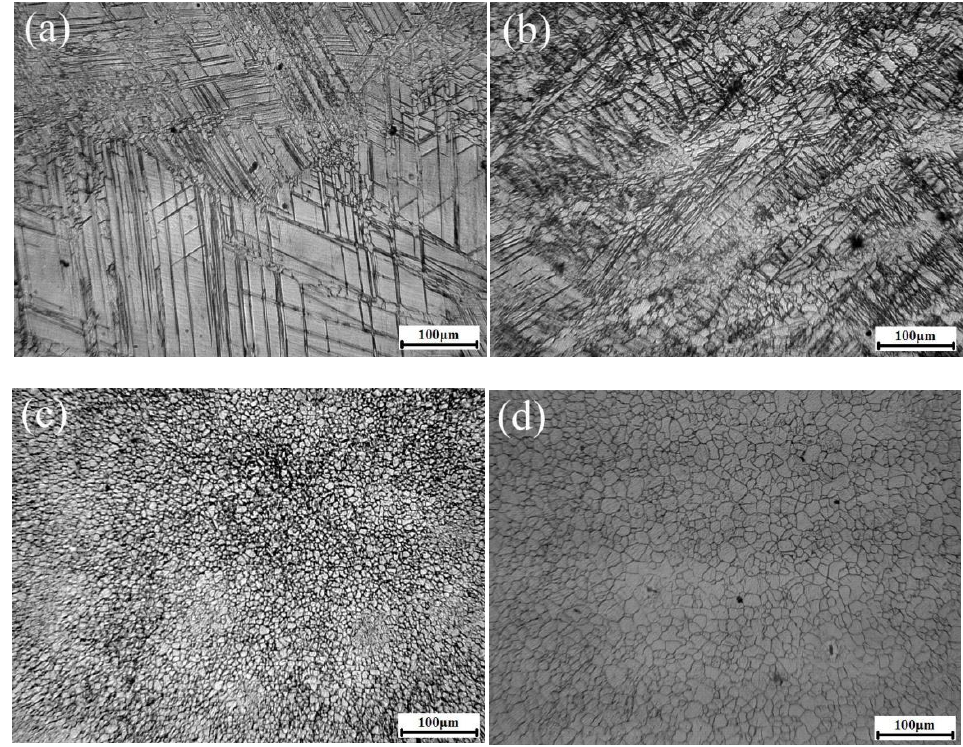
Figure 4. Microstructure of HSRBFed AZ31 alloys with different accumulated strains ( a ) 0.22, ( b ) 0.44, ( c ) 0.88, ( d ) 1.32